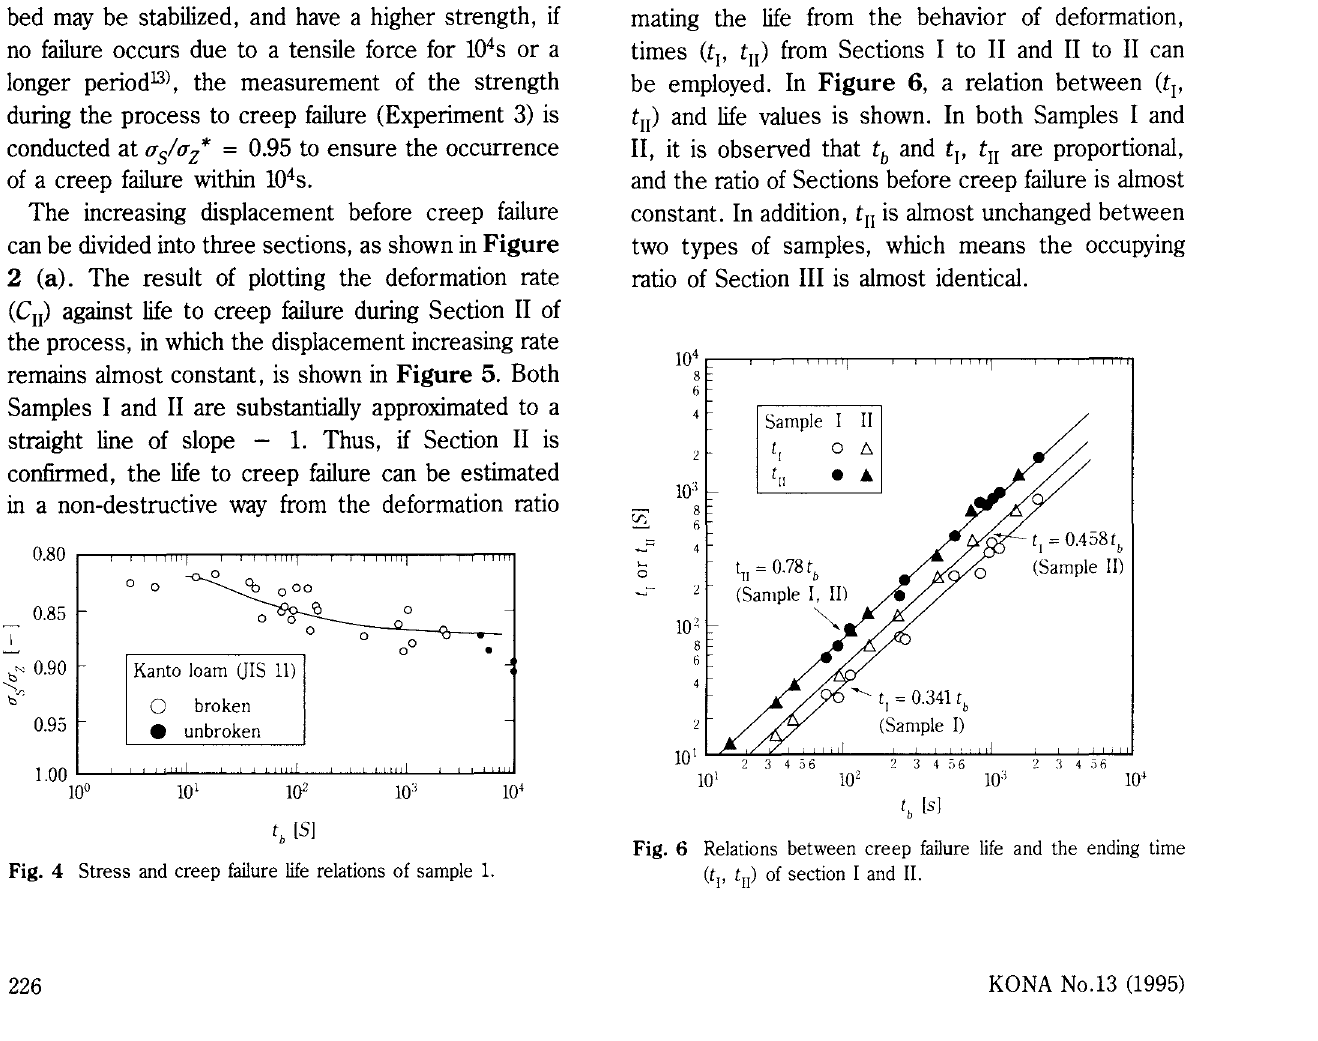
Fig. 6 Relations between creep failure life and the ending time (tl' t 11) of section I and